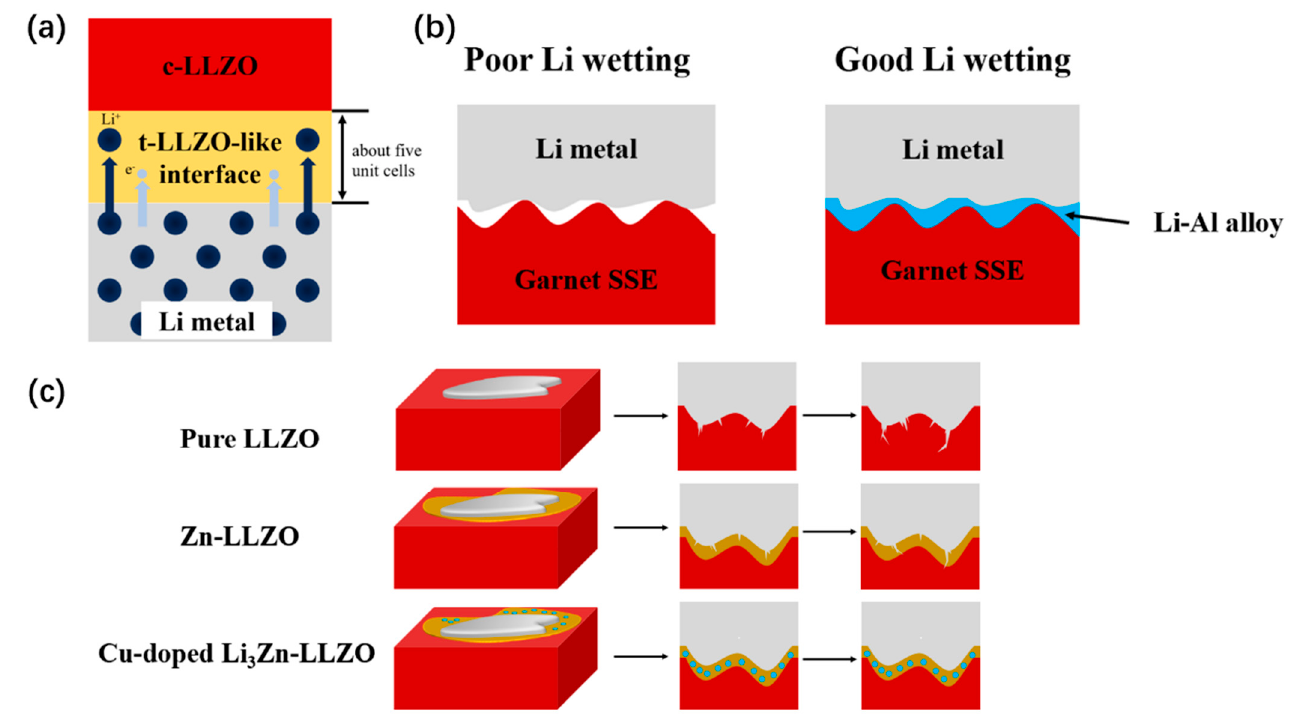
Figure 3. ( a ) Schematic of the interface behavior between c-LLZO and Li metal. A t-LLZO-like interphase is formed because c-LLZO is reduced and receives Li + from Li metal. ( b ) Schematic of garnet SSE/Li interface with Li-Al alloy. The pristine garnet SSE has poor contact with Li. Al-coated garnet SSE exhibits good contact with Li due to the formation of Li-Al alloy. ( c ) Schematics of lithium deposition on the pure, Zn- and Cu-doped Li 3 Zn-LLZO’s interface. The Cu-doped Li 3 Zn interface prevents the growth of Li dendrite.